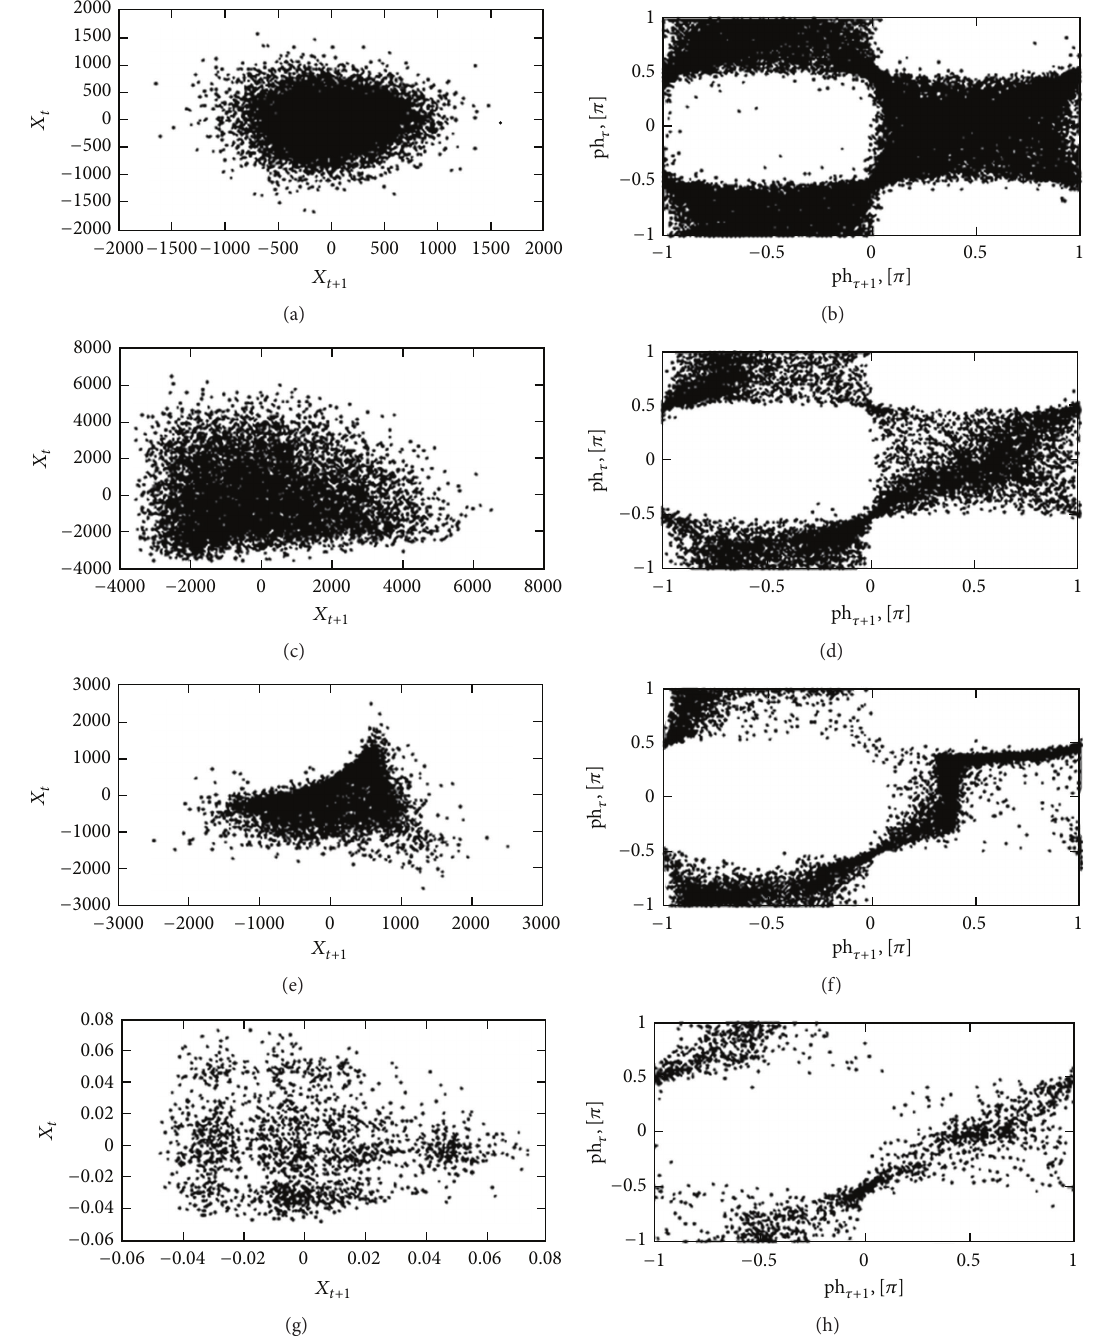
Figure 9: Reconstructed phase space portrait ( 𝑋(𝑡) versus 𝑋(𝑡 + 1) ) and phase-return map for (a) pressure signal from Kistler type 7261 transducers (multiple bubbling regime); (b) pressure signal from Kistler type 7261 transducers (exploding bubbling regime); (c) pressure signal from Kistler type 7261 transducers (single bubbling regime); (d) pressure fluctuation AP32 KEYENCE (slugging regime).